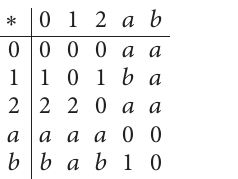
Table 3: Tabular representation of the hesitant fuzzy soft set